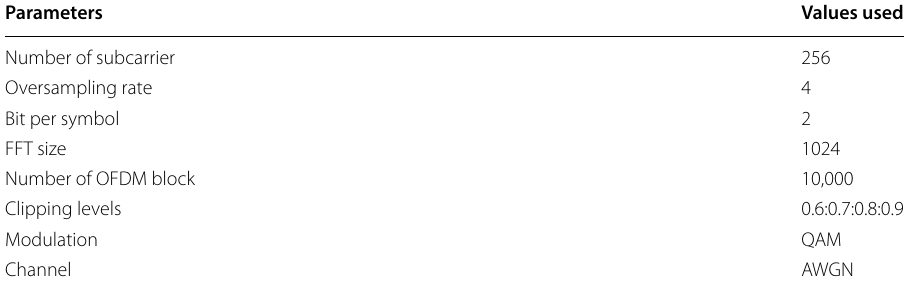
Table 2 Simulation parameters on the effect of threshold clipping level Parameters